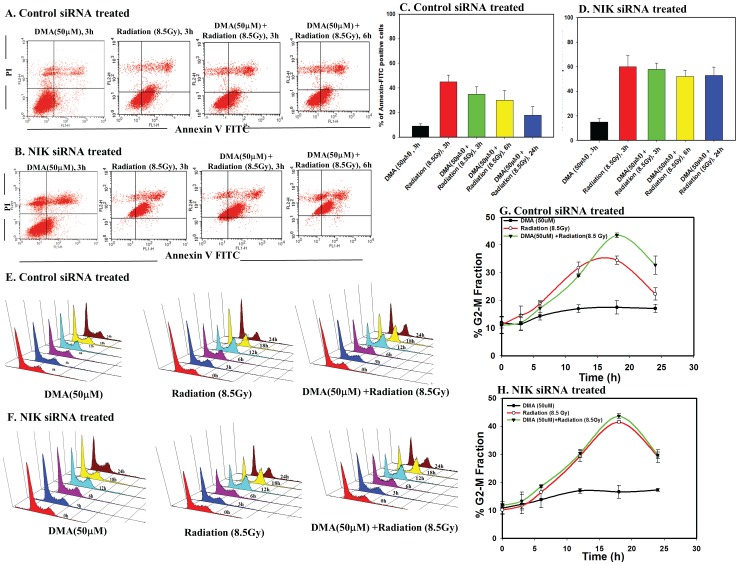
DMA attenuates radiation induced apoptosis in U87 through NIK.(A) Apoptosis analysis of control siRNA transfected U87 cells at 3 h, 6 h in different treatment condition i.e. 50 µM DMA, radiation (8.5 Gy) and DMA (50 µM) + Radiation (8.5 Gy). Percentage of apoptosis is defined by % of cells that are Annexin V+ and Annexin V +PI+. (B) Apoptosis analysis of siRNA-NIK transfected U87 cells at 3 h, 6 h in different treatment condition i.e. 50 µM DMA, radiation (8.5 Gy) and DMA (50 µM) + Radiation (8.5 Gy). Percentage of apoptosis is defined by % of cells that are Annexin V+ and Annexin V +PI+. (C) Percentage of Annexin V+ and Annexin V +PI+.positive cells in control siRNA transfected U87 cells at, 3 h,6 h, and 24 h in different treatment condition i.e. 50 µM DMA, radiation (8.5 Gy) and DMA (50 µM) + Radiation(8.5 Gy). (Data Not shown for 6 h and 12 h for only DMA and only radiation treatment condition). (D) Percentage of ofAnnexin V+ and Annexin V +PI+.positive cellssiRNA-NIK transfected U87 cells at 3 h, 6 h, and 24 h in different treatment condition i.e. 50 µM DMA, radiation (8.5 Gy) and DMA (50 µM) + Radiation (8.5 Gy).(Data Not shown for 6 h and 12 h for only DMA and only radiation treatment condition). (E) Time course graphs showing the progression of cell cycle of control siRNA transfected U87 cells at 0, 3, 6, 12, 18 and 24 h in different treatment condition i.e. 50 µM DMA, radiation (8.5 Gy) and DMA (50 µM) + Radiation(8.5 Gy). (F) Time course graphs showing the progression of cell cycle of siRNA-NIK transfected U87 cells at 0, 3, 6, 12, 18 and 24 h in different treatment condition i.e. 50 µM DMA, radiation (8.5 Gy) and DMA (50 µM) + Radiation(8.5 Gy). (G) Cell cycle progression of control siRNA transfected U87 cells showing % G2-M fraction at 0, 3, 6, 12, 18 and 24 h in different treatment condition i.e. 50 µM DMA, radiation (8.5 Gy) and DMA (50 µM) + Radiation(8.5 Gy). (H) Cell cycle progression of siRNA-NIK transfected U87 cells showing % G2-M fraction at 0, 3, 6, 12, 18 and 24 h in different treatment condition i.e. 50 µM DMA, radiation (8.5 Gy) and DMA (50 µM) + Radiation(8.5 Gy).